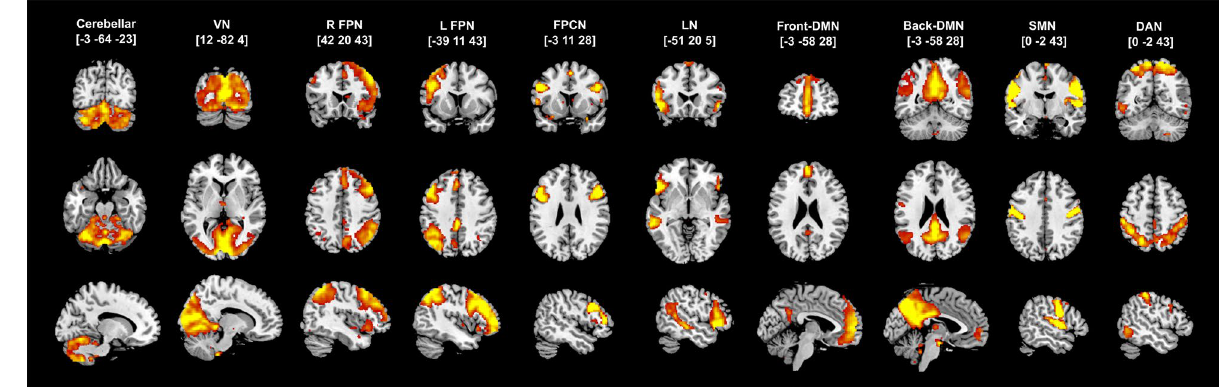
Figure 2. Ten ICA components utilized for the rs-dFC